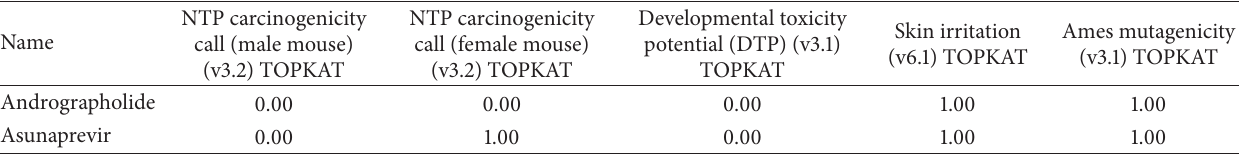
Table 3: Comparison of the predicted TOPKAT values of ligands.